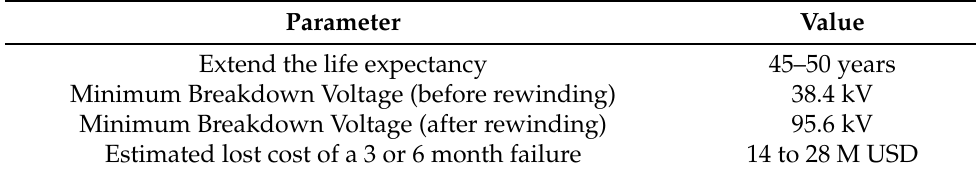
Figure 12. Temperature data acquisition software screen outputs of the generator ( a ) and its radiator unit ( b ). Table 1. Techno-economic results after implementing the modernised hydropower Chivor II operat- ing